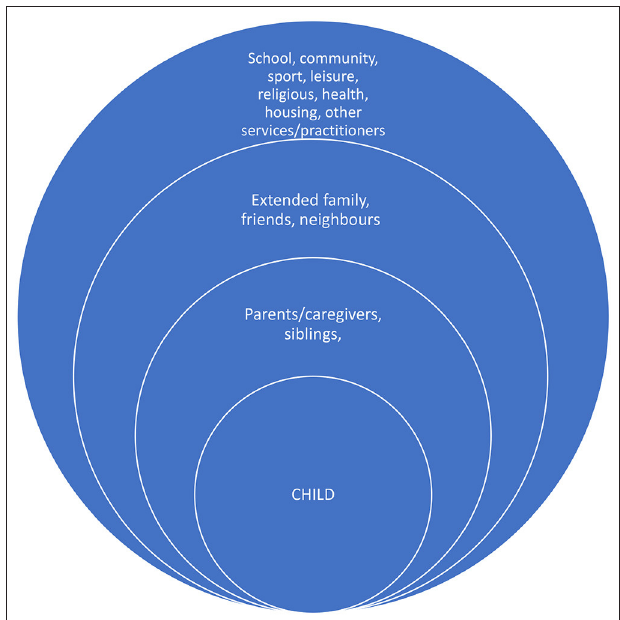
FIGURE 1 | Possible connections for families living in